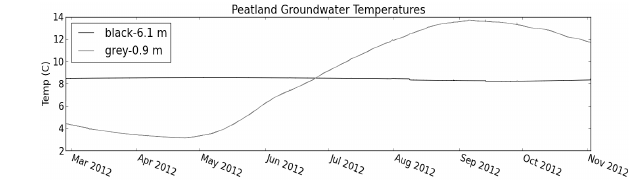
Fig. 9. Temperature data from 0.9 and 6.1m monitoring wells equipped with pressure transducers. Temperatures were constant in deep peat allowing for constant CH 4 production.